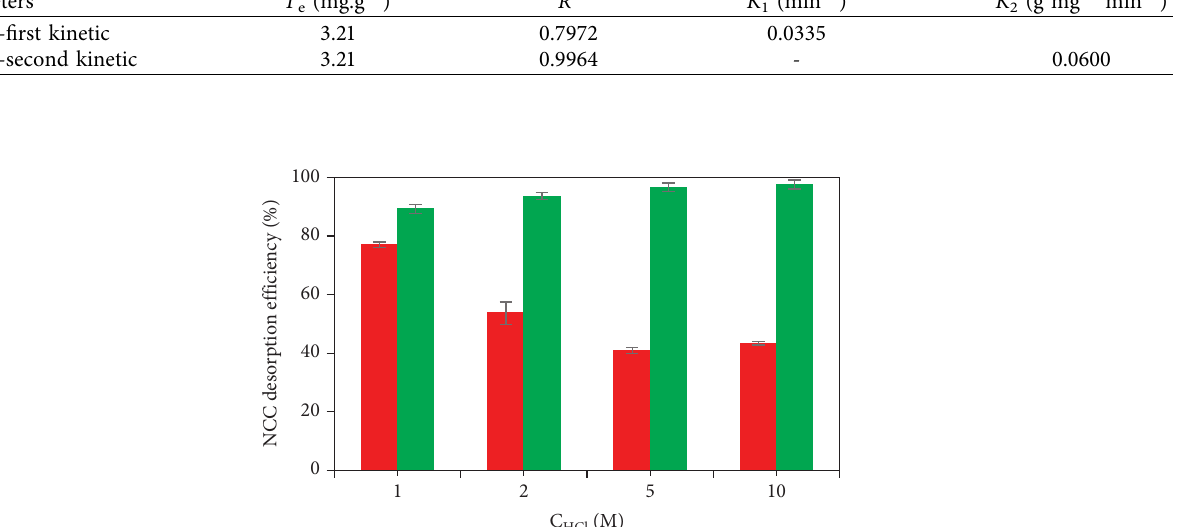
2 O 3 adsorbent with different HCl treatment times: ( ) 1